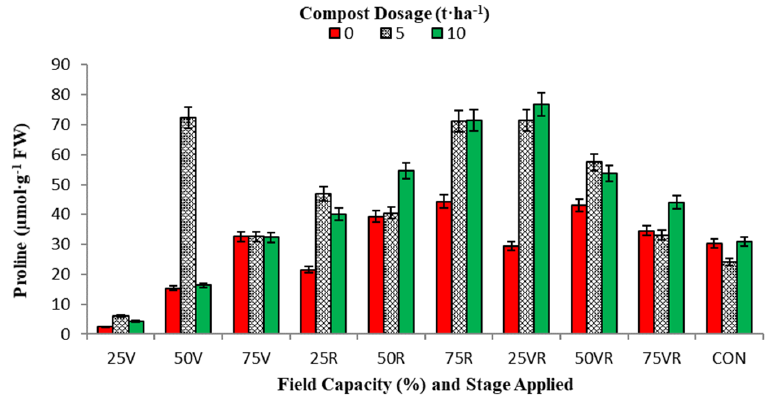
Figure 20. Effect of interaction of water regime, treatment stage and compost dosage on proline content of okra leaf at 8 weeks The 25, 50 and 75% represent field capacity; V (vegetative), R (reproductive), and VR (vegetative and reproductive) represent the stage at which the deficit was applied. Data in the interaction analysed with Least Squares Means, and means separated with